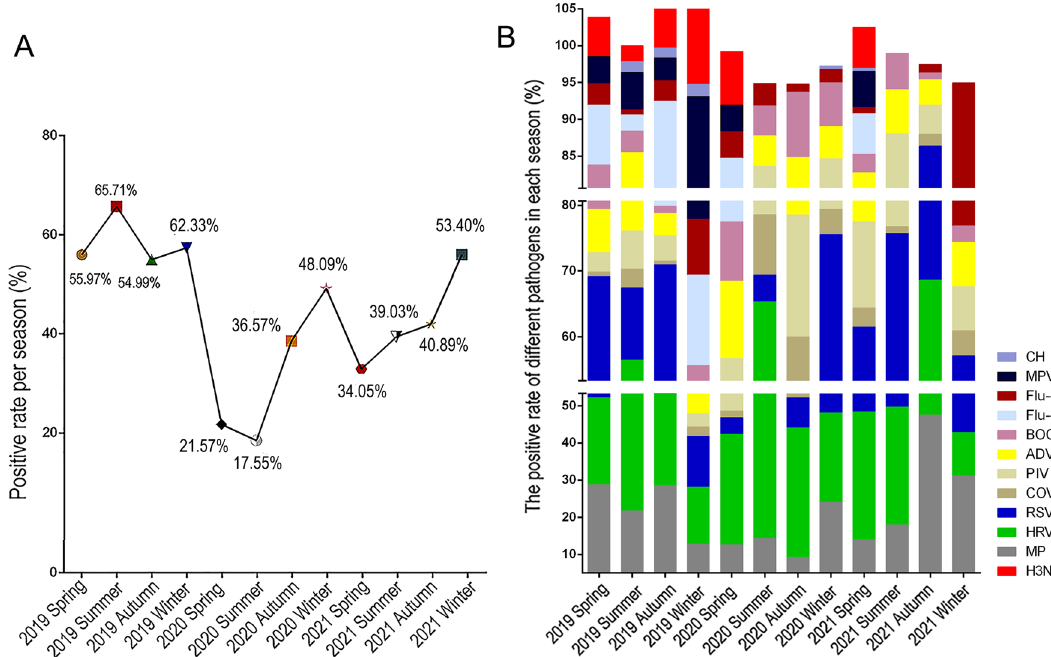
Figure 4. Detection of respiratory pathogens in different seasons after the COVID-19 pandemic. ( A ) The positive rates of pathogens in different seasons. ( B ) Seasonal distribution of positive detected pathogens during 2019 and